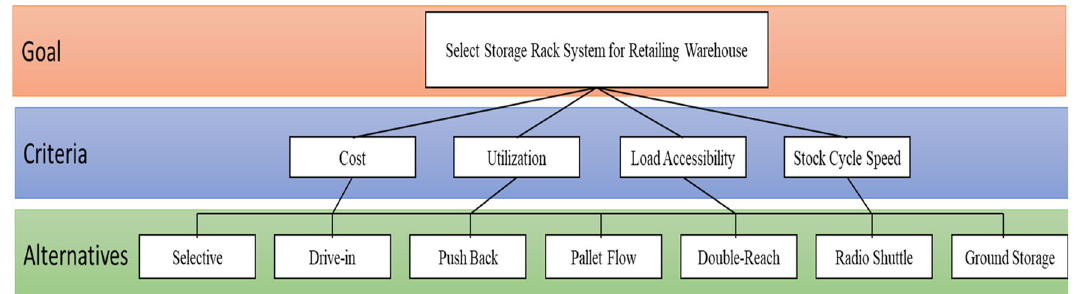
Fig. 5 Retail layout based on class-based policy